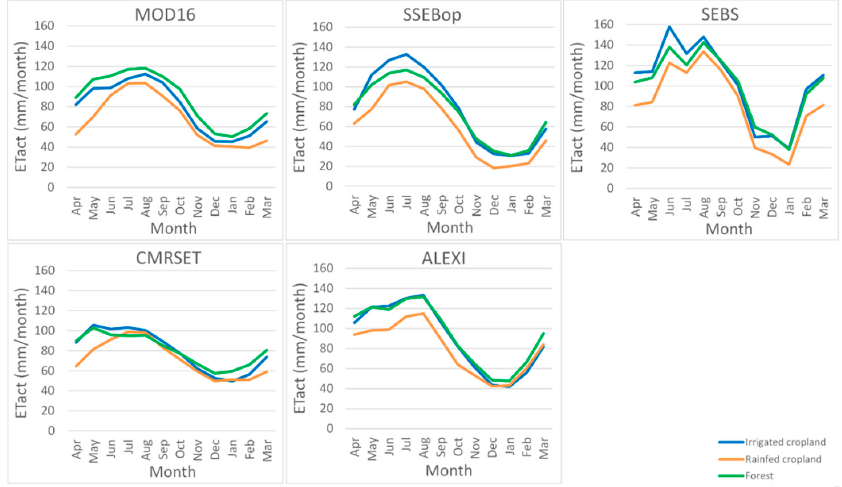
Figure 6. Average monthly ET act for three LULC types.